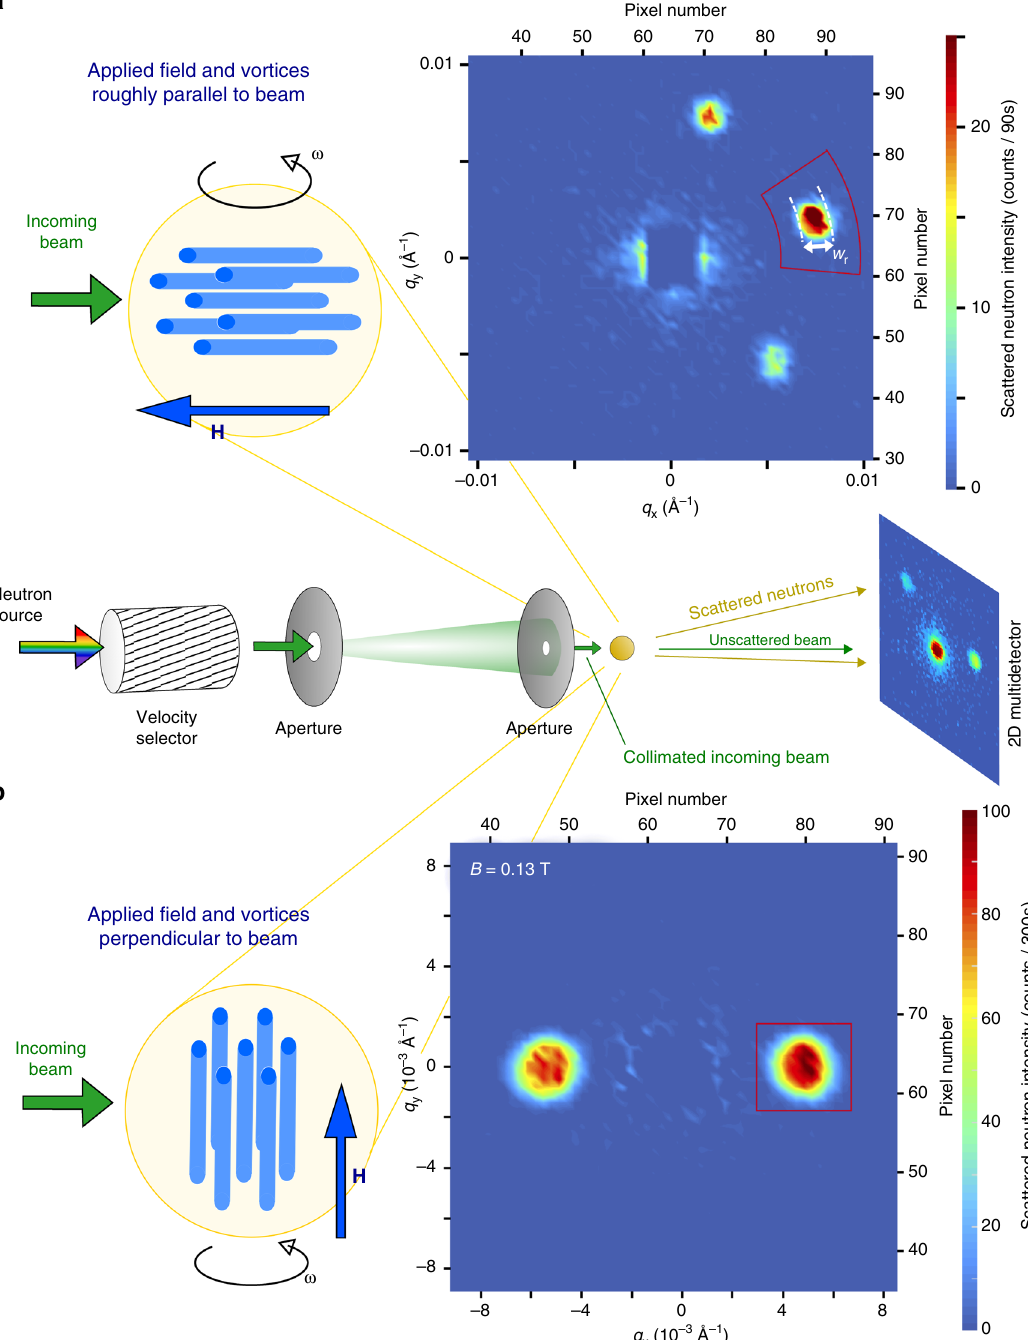
Fig. 2 Neutron scattering geometries. Small-angle neutron scattering (SANS) instruments are usually pinhole cameras with small apertures to tightly collimate the incoming neutron beam. The magnetic fi eld pro fi le presented by vortices in the sample diffracts neutrons. Rocking curves are collected by rotating the sample, fi eld and vortices together through the Bragg condition. Two experimental geometries may be used, exploiting the signi fi cantly better instrument resolution in the direction probed by the rocking curve: ( a ) The applied magnetic fi eld and vortices are orientated roughly parallel to the neutron beam. Here the rocking curve is most sensitive to correlations along the vortices. A typical image of the 2D SANS multidetector at the peak of the rocking curve of the right Bragg spot is shown. The rotation axis for this rocking curve is indicated by ω . The unscattered neutron beam in the centre of the image at q = 0 is blocked by a beamstop. ( b ) The rocking curve probes correlations in the plane of the vortices when the applied magnetic fi eld and vortices are orientated perpendicular to the neutron beam. The detector image shows the peak of the rocking curve of the right spot at 0.13